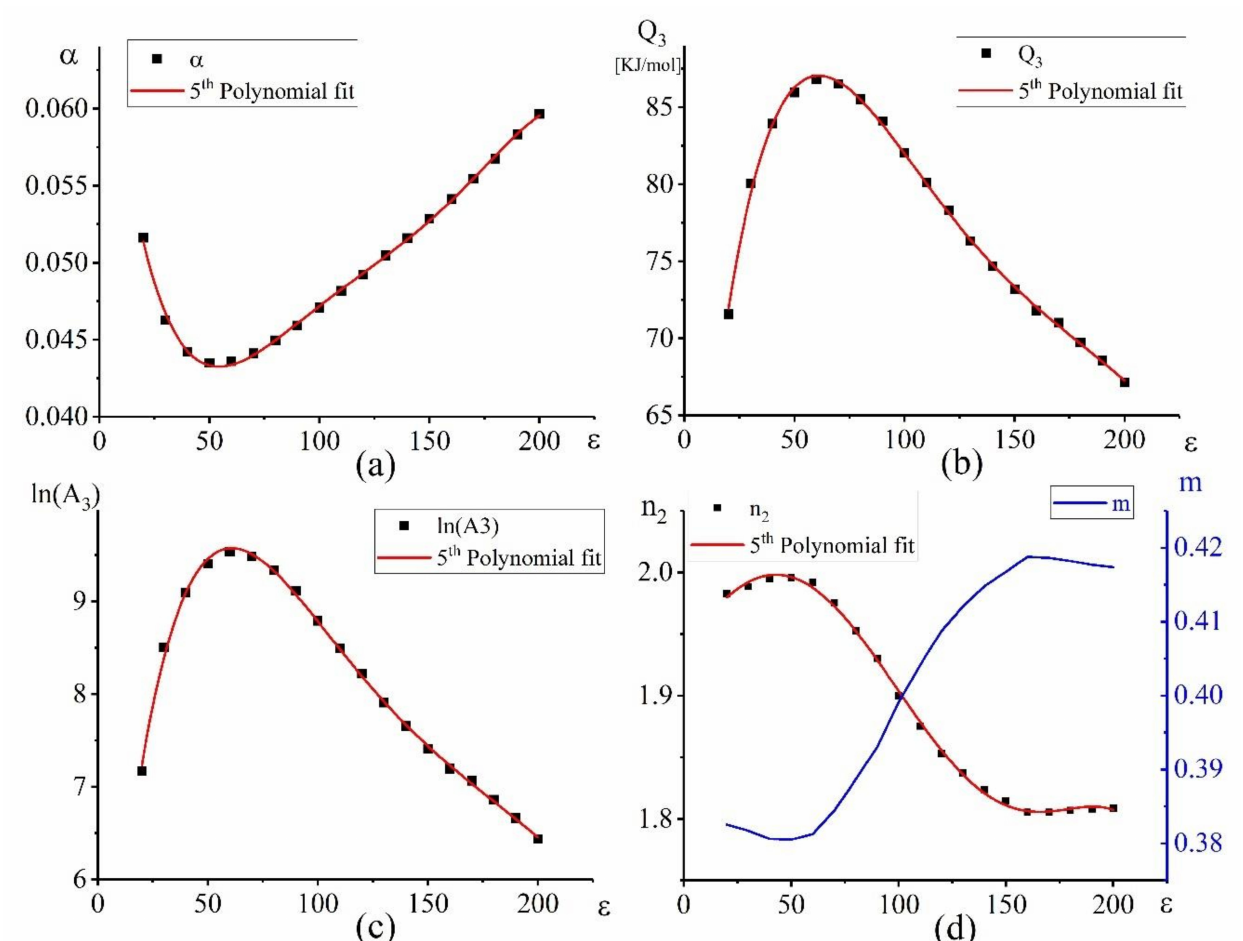
Figure 6. Dependence of the ( a ) α , ( b ) Q 3 , ( c ) ln(A 3 ), and ( d ) n 2 vs. strain. The 5th polynomial order was the best relevant order, depending on the